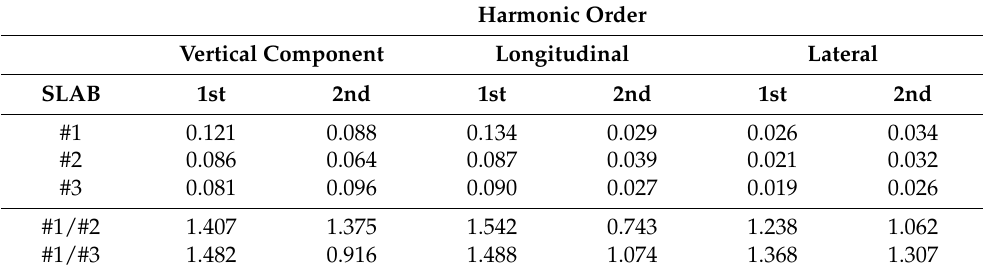
Table 4. Average trend of FFT peak amplitudes, as obtained from experimental spectra (normalized with respect to the weight of pedestrian) for vertical, longitudinal, and lateral force components on different substructures. Harmonic Order Vertical Component